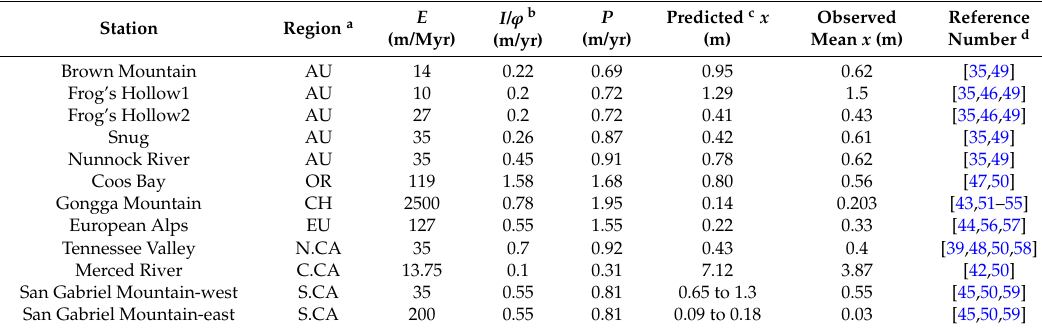
Table 1. Predicted soil depths from reasonable infiltration and given erosion rates.